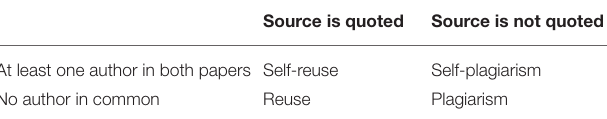
TABLE 8 | Language resources impact factor (data and tools). TABLE 9 | Definition of